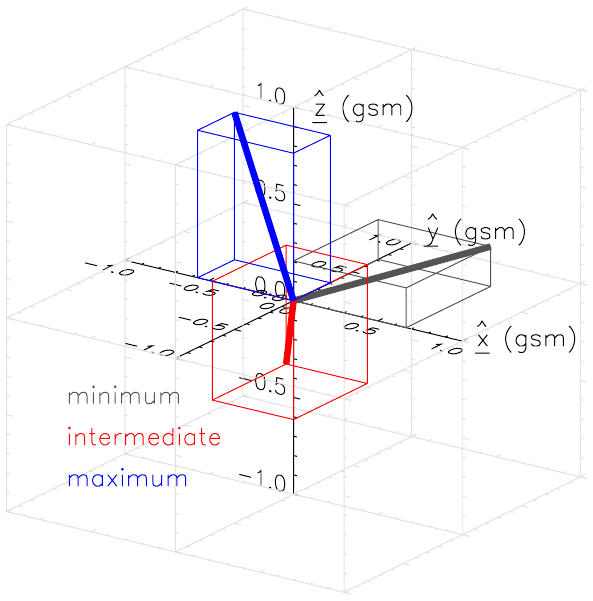
Fig. 4. A 3-D view of the variance system in GSM unit space from Cluster 1 for the 2 October 2003 event. The minimum vari- ance direction is coloured black, intermediate variance direction is coloured red and maximum variance direction is coloured blue. Thin tracer lines are plotted giving the projections onto the GSM unit axes as a guide to the direction of the vectors.